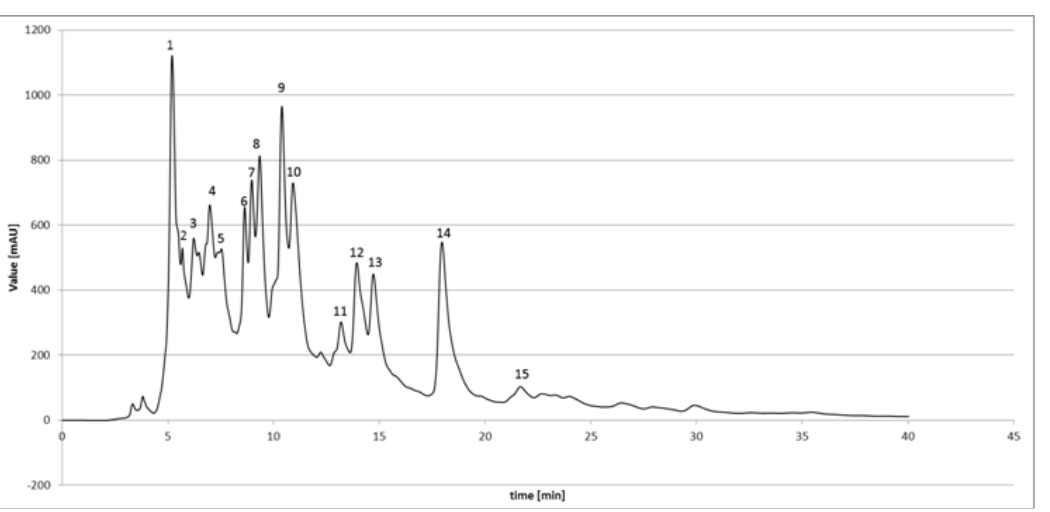
Figure 1. HPLC chromatogram of propolis ethanolic extract from Poland. 1-Cinnamic acid (Rt-5.20); 2- p -Coumaric acid (Rt-5.69); 3-Ferulic acid (Rt-6.23); 4-Gallic acid (Rt-6.98); 5-Caffeic acid (Rt-7.36); 6-Caffeic acid phenethyl ester (Rt-8.63); 7-Pinobaksin (Rt-8.97); 8-Kaempferol (Rt-9.34); 9-Apigenin (Rt-10.40); 10-Pinocembrin (Rt-10.92); 11-Quercetin (Rt-13.19); 12-Chrysin (Rt-13.93); 13-Galangin (Rt-14.72); 14-Acecetin (Rt-17.46); 15-Kampferide (Rt-21.67); Rt- retention time (min).